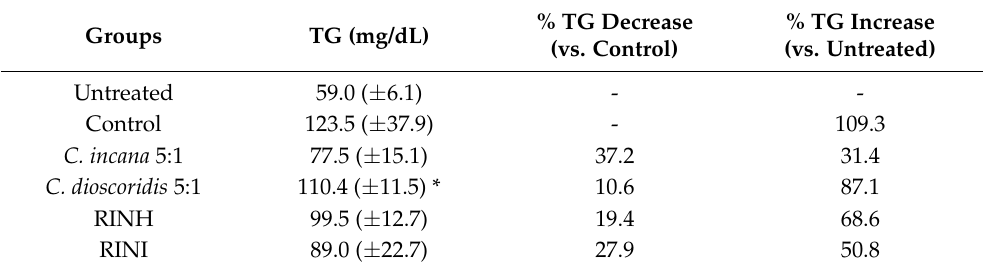
Table 6. Effect of extract C. incana 5:1, C. dioscoridis 5:1 and fractions RINH, RINI on triglyceride plasma levels